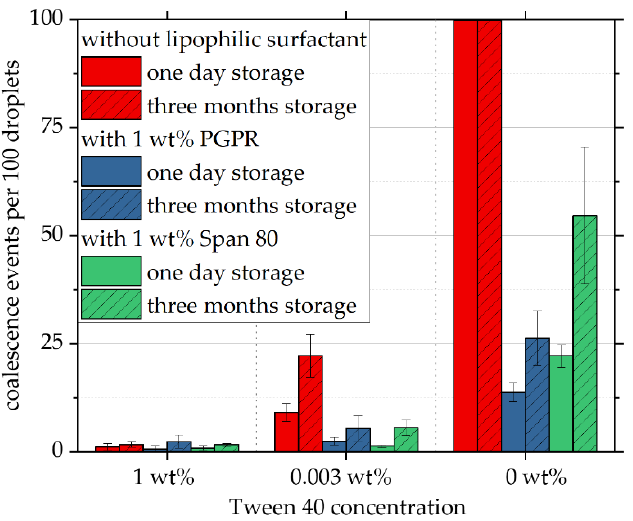
Figure 5. Number of coalescence events within the microfluidic emulsions ( d = 144 µm; CV < 3%) after one day and after three months. On the x-axis, the concentration of Tween 40 is varied. In the oil phase, either 1 wt% PGPR, 1 wt% Span 80 or no lipophilic surfactant were added.